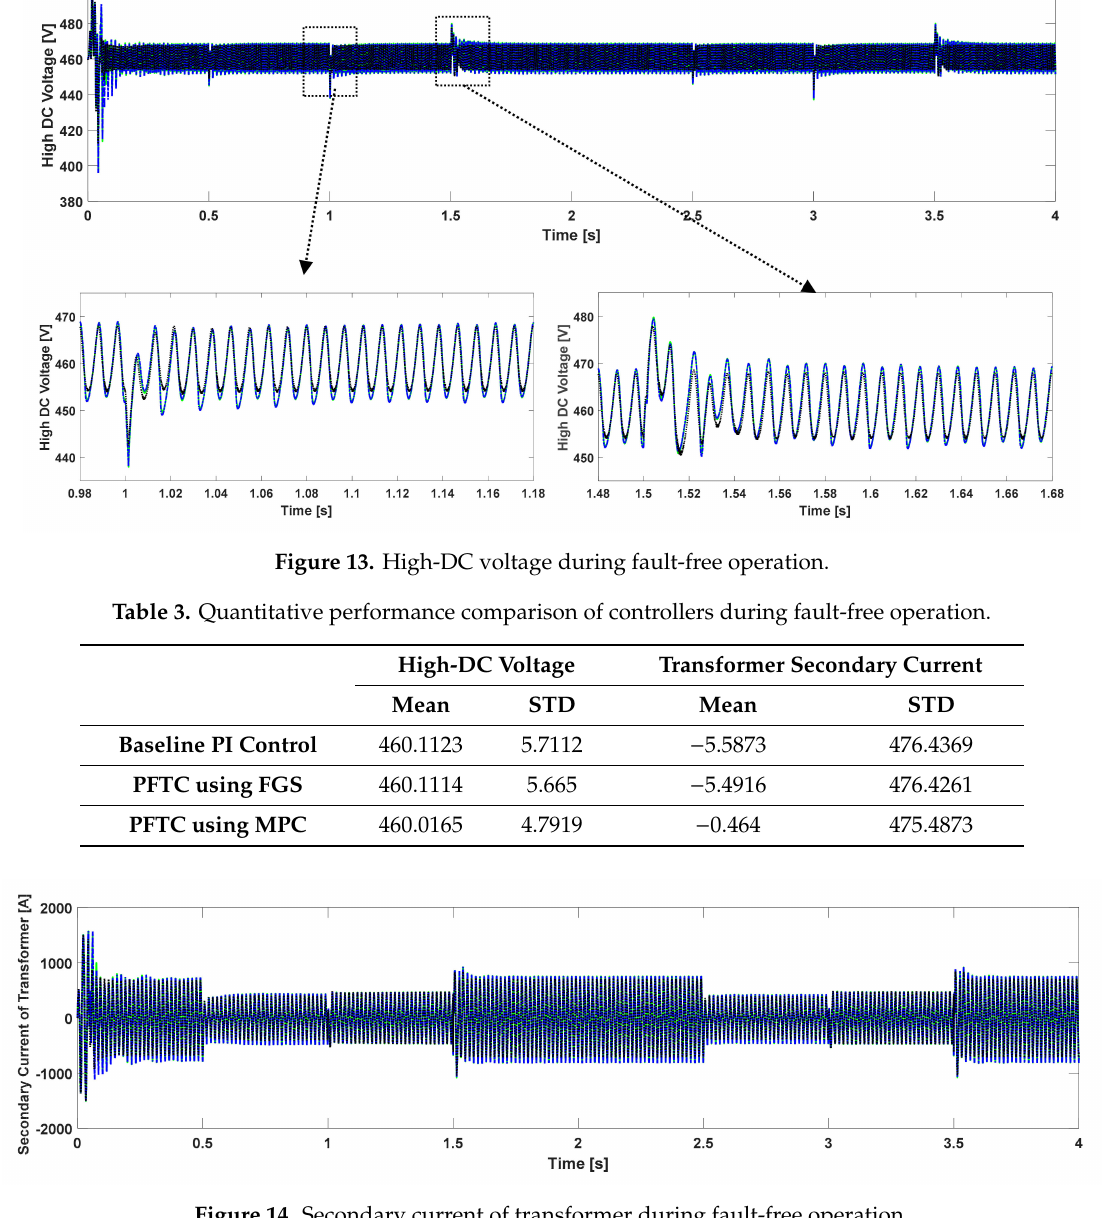
Figure 14. Secondary current of transformer during fault-free operation.